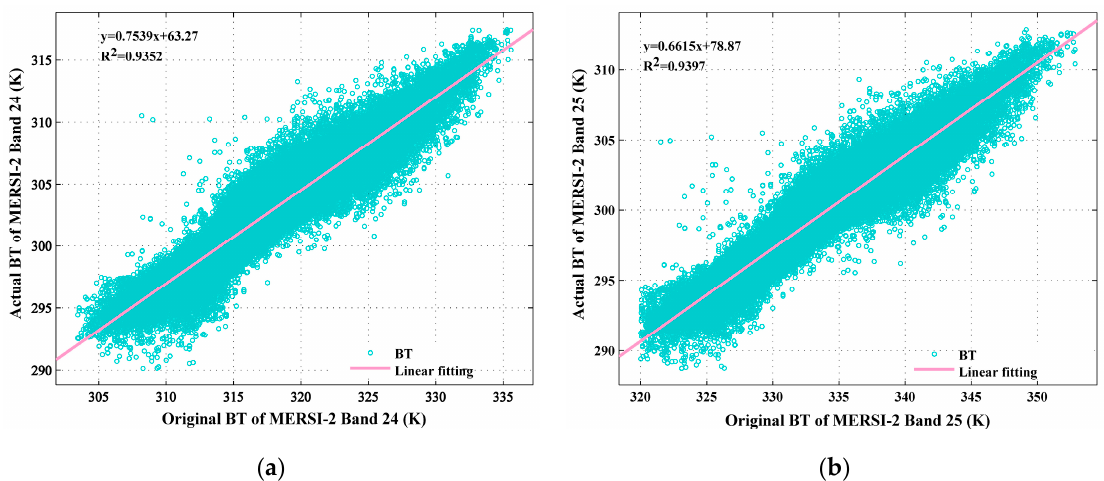
Figure 6. The relationship between the BT of MERSI-2 Band 24 ( a ) and Band 25 ( b ) images and the